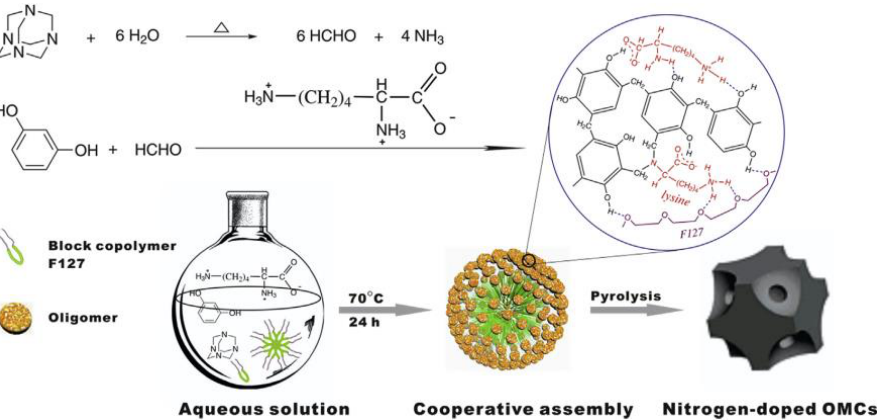
Figure 31. Schematic illustration of L-lysine-assisted formation of cubic nitrogen-doped ordered mesoporous carbons (OMCs) (reproduced from the work in [96] with permission).